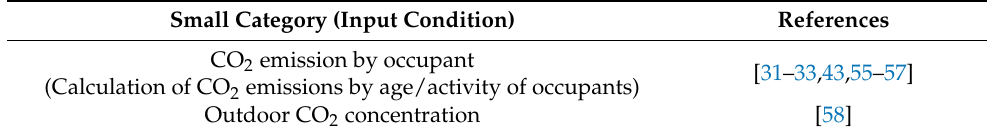
Table 6. Input conditions for factors influencing CO 2